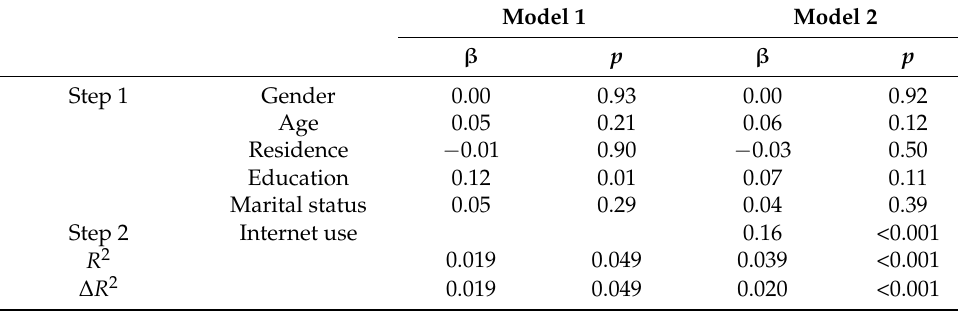
Table 4. Hierarchical regression analysis on health status in Sample 1 (N = 598).